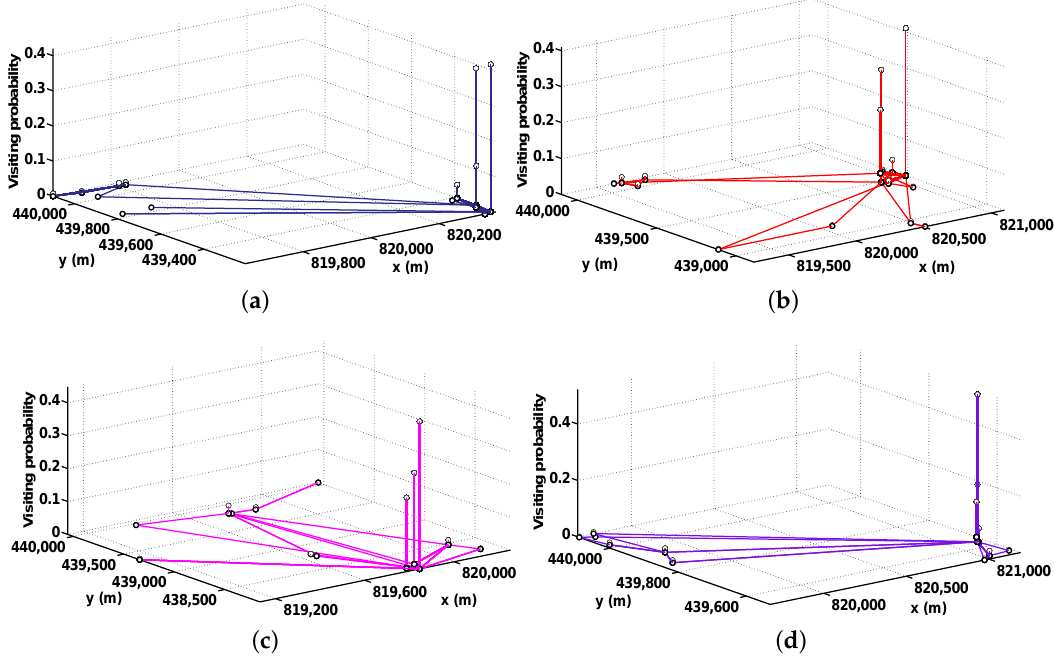
Figure 1. The snapshots of four mobile nodes: ( a ) from the data set 21 September 2003 to 20 October 2003; ( b ) from the data set 21 October 2003 to 19 November 2003; ( c ) from the data set 28 January 2004 to 26 February 2004; and ( d ) from the data set 20 April 2004 to 19 May